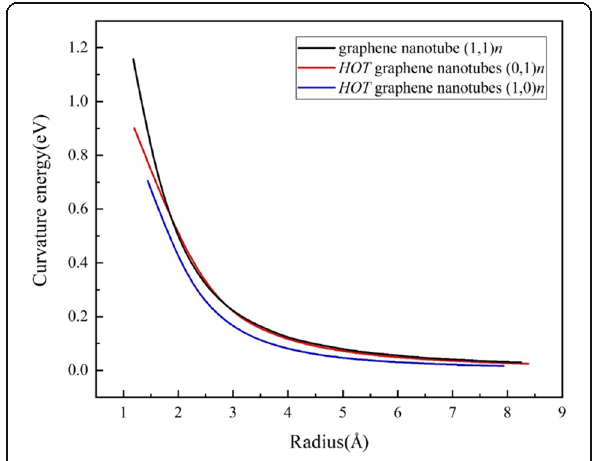
Fig. 4 Curvature energies of the HOT graphene nanotubes and graphene